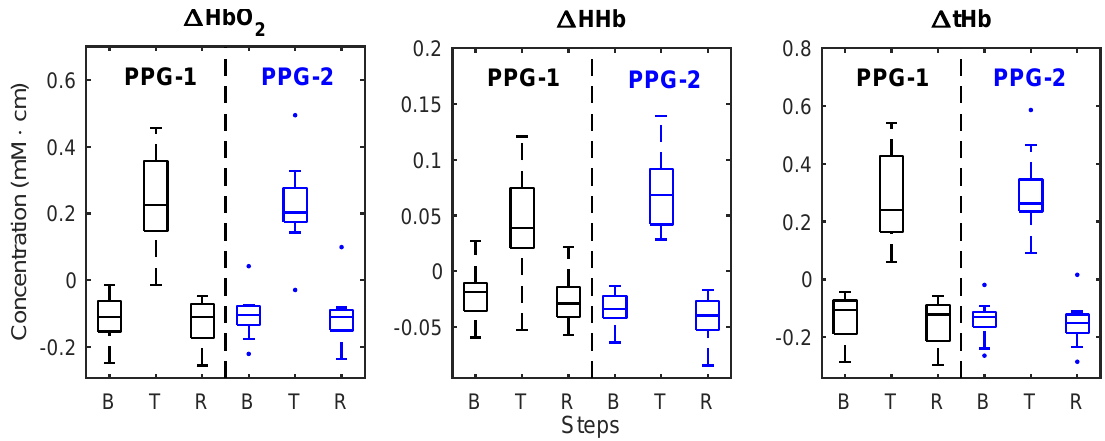
Figure 7. Box and whiskers plot of the mean changes in ∆ HbO 2 , ∆ HHb, and ∆ tHb measured by the two PPG sensors during baseline (B), tilting (T) and recovery (R). PPG-1: sensor positioned on top of the large vein; PPG-2: sensor placed on the vein-free area above the eyebrow.